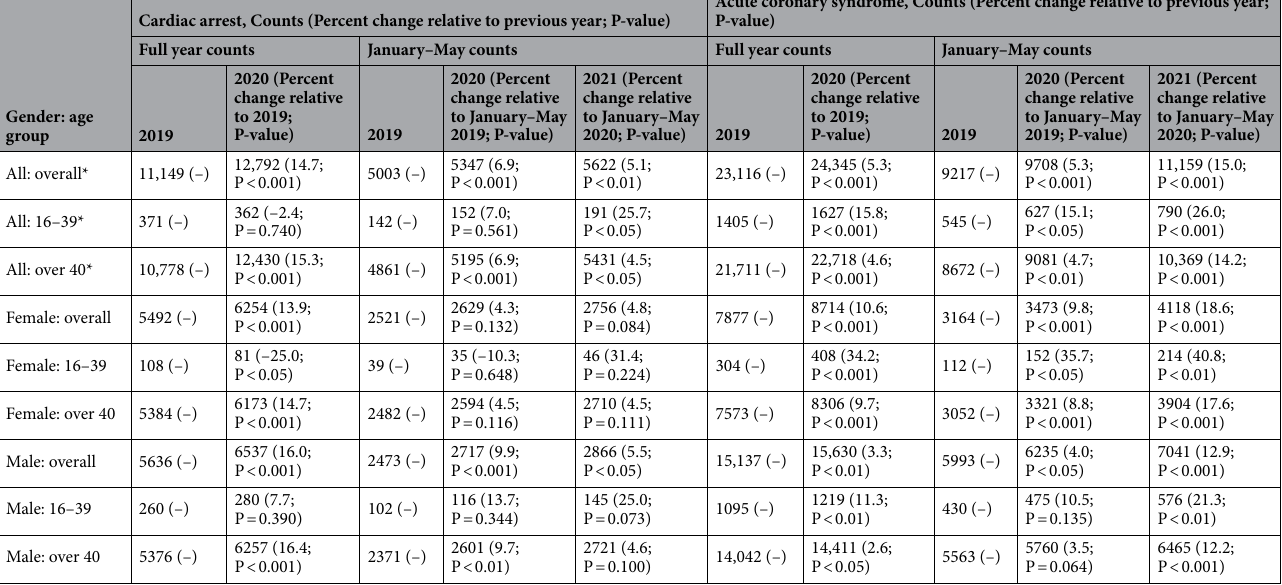
Table 1. Year-to-year absolute and relative changes in the counts of cardiac arrest and acute coronary syndrome calls by age group and gender. Each cell shows the counts of calls during the respective time period, age group, and gender with the relative percent change in counts to the previous year shown in the parenthesis (e.g., relative change from 2019 to 2020, and then from 2020 to 2021). The relative percent changes were calculated across the same duration per year (i.e., either across the full year or across the January–May period). For counts during 2019, no relative change is reported. *Counts in the All category includes calls with missing gender variable values. Number of calls with missing gender values: Cardiac arrest: N = 119 and Acute Coronary syndrome: N =